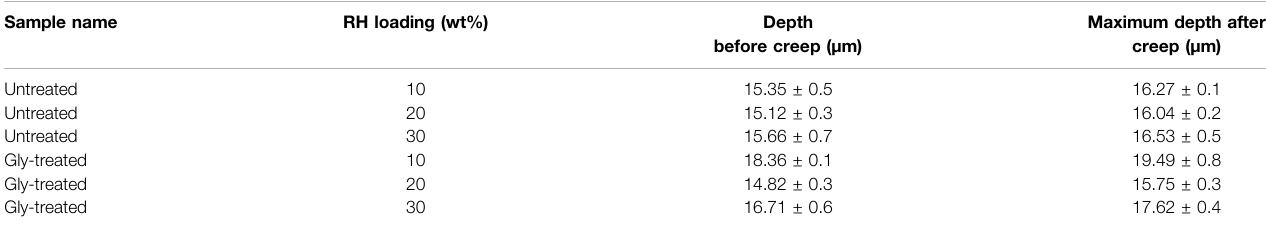
TABLE 2 | Maximum contact depth achieved in biocomposites with standard